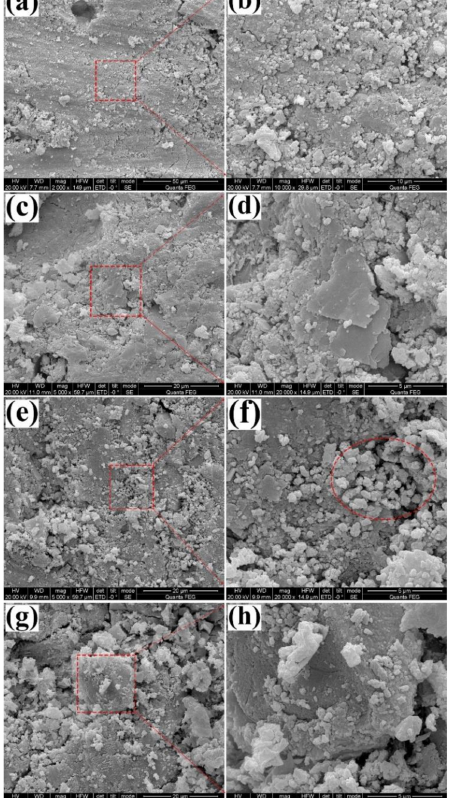
Figure 5. Surface field emission scanning electron microscope (FE-SEM) images of di ff erent HCPs at di ff erent magnifications: ( a , b ) pure HCP; ( c , d ) HCP modified with 1.0 wt.% SL; ( e , f ) HCP modified with 1.0 wt.% NS; ( g , h ) HCP modified with 1.0 wt.% SL and 1.0 wt.% NS